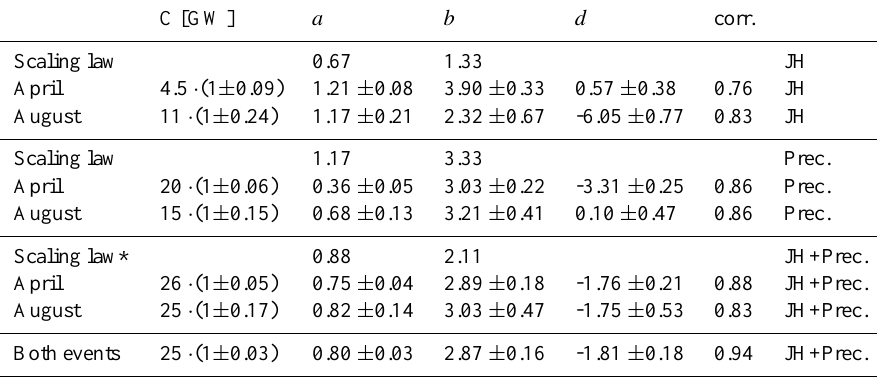
Table 3. Power law fittings. C [GW] a b d corr. Scaling law